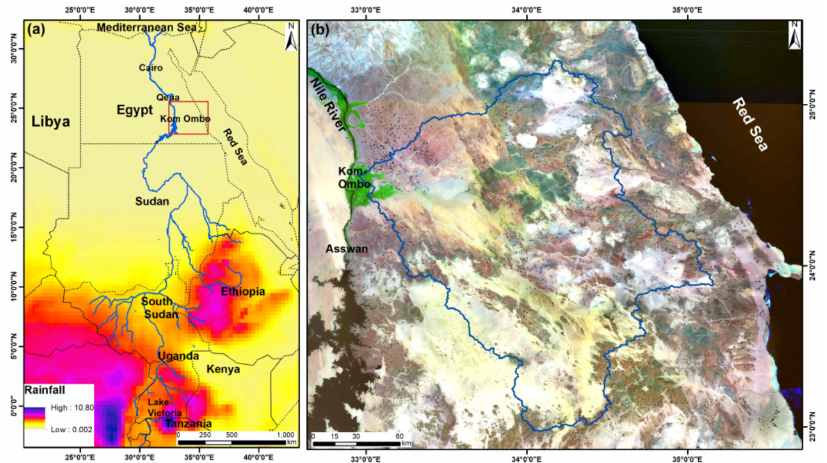
Figure 1. ( a ) Rainfall distribution map derived from the Tropical Rainfall Measuring Mission (TRMM) satellite covering the Nile basin, Africa (1 January 1998 to 30 November 2013); ( b ) Landsat-7 mosaic of the Kom Ombo area, Southern Egypt.